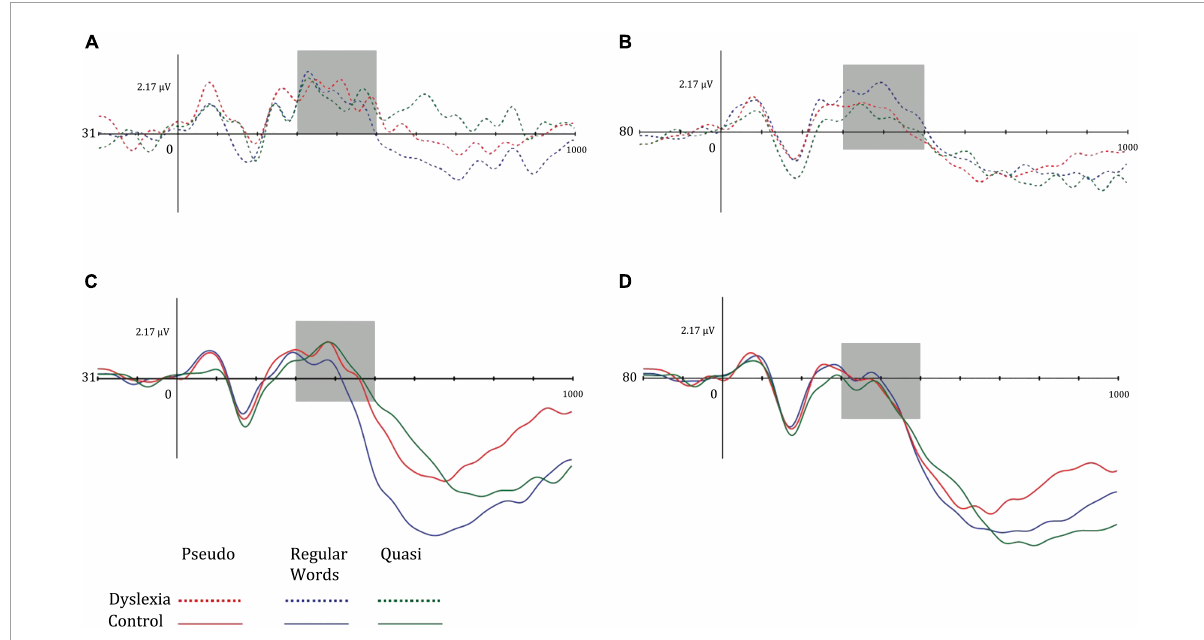
FIGURE5 Mean amplitude of the left mid-parietal N400 component for (A) dyslexia group and left hemisphere, (B) dyslexia group and right hemisphere, (C) control group and left hemisphere, and (D) control group and right hemisphere. Dotted lines represent the dyslexia group, while solid lines represent the control group. Red-colored lines represent pseudo words, blue-colored lines represent regular words, and green-colored lines represent Quasi